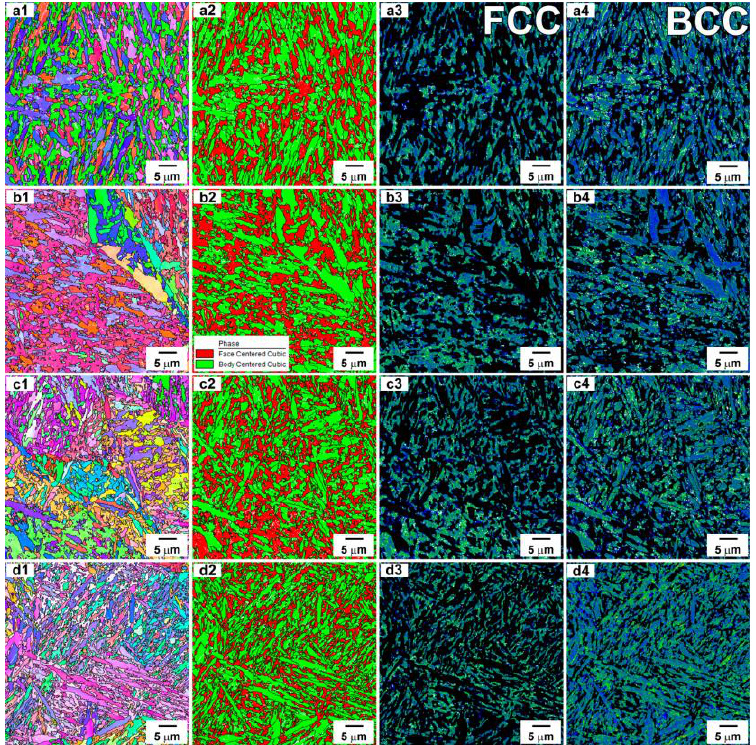
Figure 5. EBSD analysis of the Fe-0.44C steel after quenching at 140 ◦ C ( a1 – a4 ), 160 ◦ C ( b1 – b4 ), 200 ◦ C ( c1 – c4 ), and 250 ◦ C ( d1 – d4 ), RA is emphasized by red color (column 2), KAM map (columns 3, 4). BCC—Body Centered Cubic; FCC—Face Centered